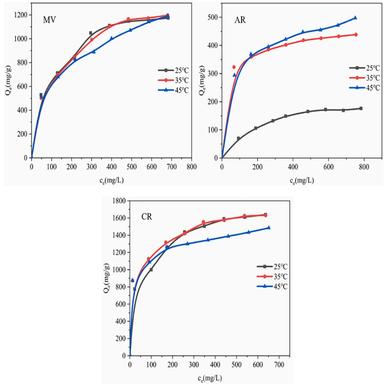
Experimental isotherms of the adsorption of dyes MV, AR and CR on CMCAC at 25–45 ◦C, pH = 6 (MV) and pH = 7 (AR, CR).